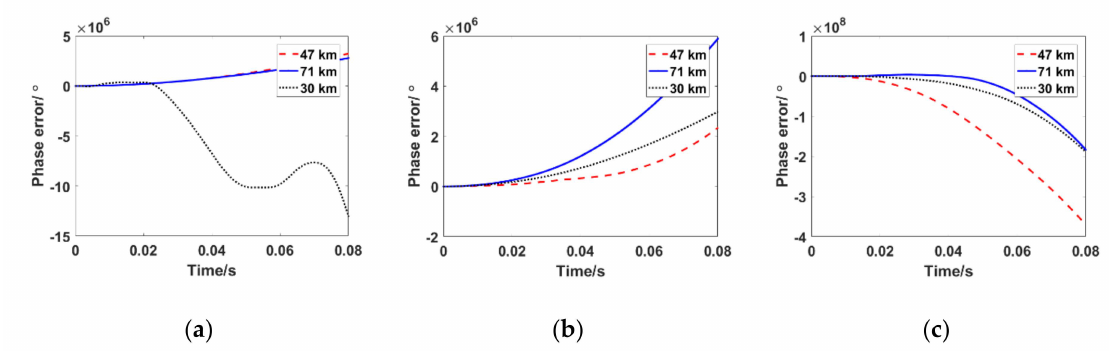
Figure 3. Phase error of the traditional phase-locked loop (PLL) under typical conditions of a time-varying plasma sheath channel (PSC). ( a ) 2.3 GHz; ( b ) 5.8 GHz; ( c ) 30